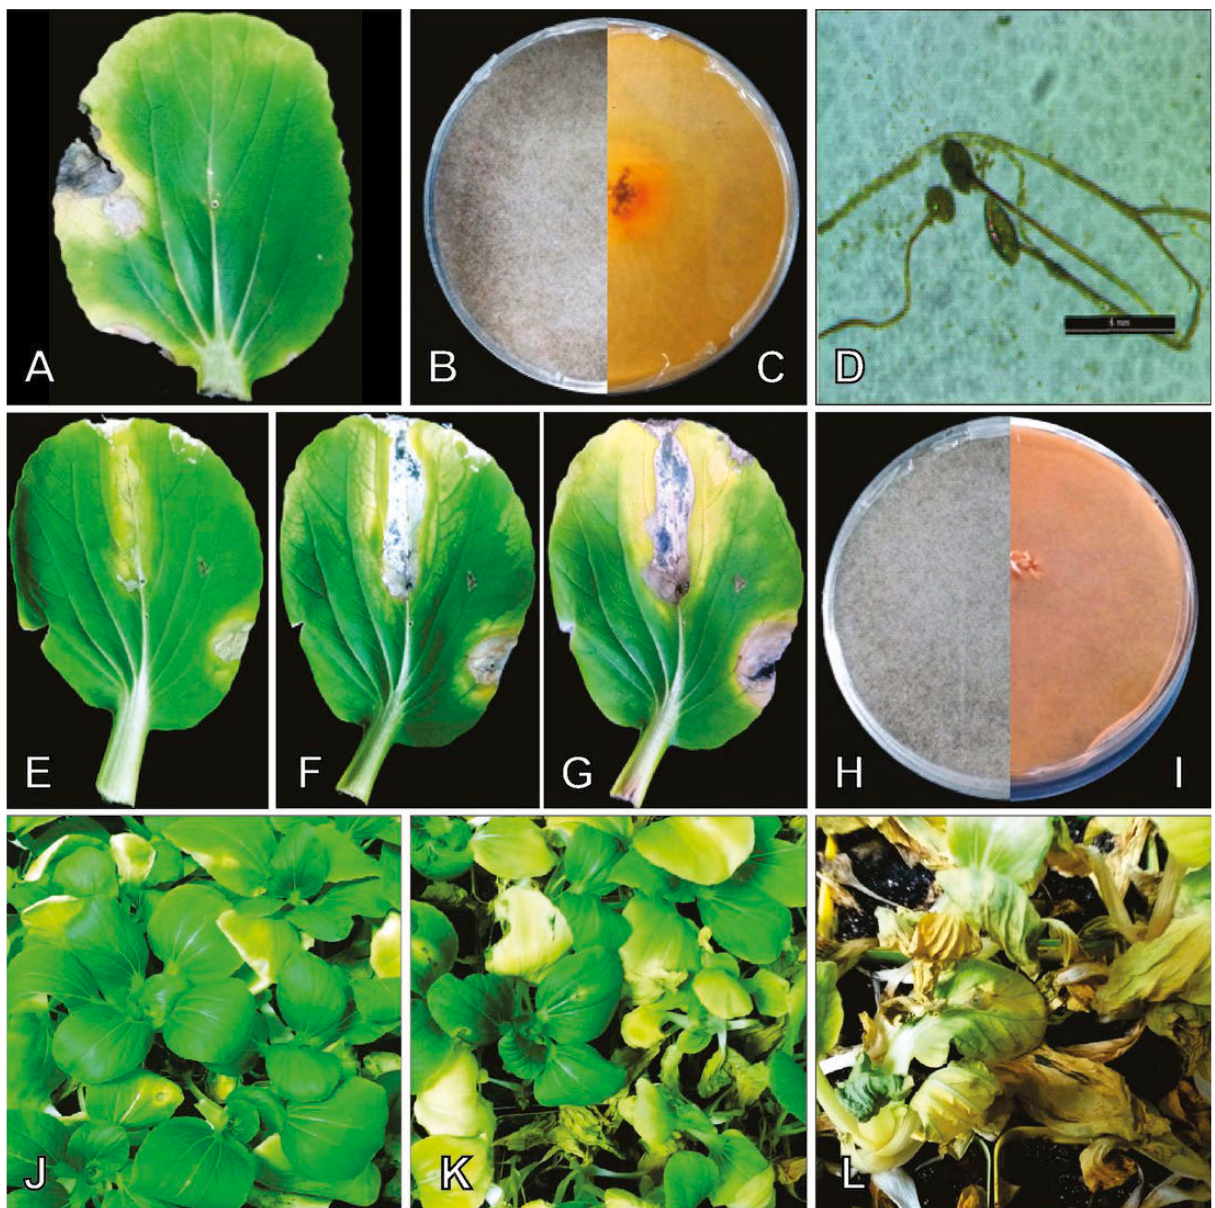
Figure 1. Disease symptoms on a leaf of pak choy (A). Disease causing pathogen was isolated on APDA and observed from front side (B) and back side (C) of Petri plates. Fungus morphology was observed under a compound microscope (D). Typical disease symptoms were observed after 4 d (E), 6 d (F) or 8 d (G) after inoculation. The inoculated pathogen was isolated from diseased leaves (H and I). After foliar inocula- tion of fresh leaves (J), lesions appeared in the 1 st first week after innoculation (K) and completely damaged plants in the 3rd week